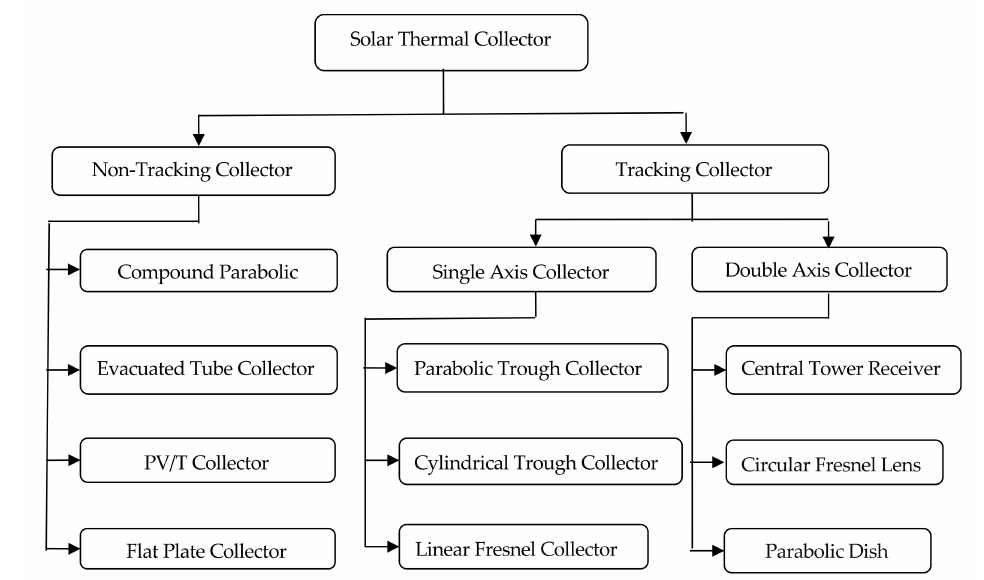
Figure 1. Classification of solar collectors by tracking arrangement